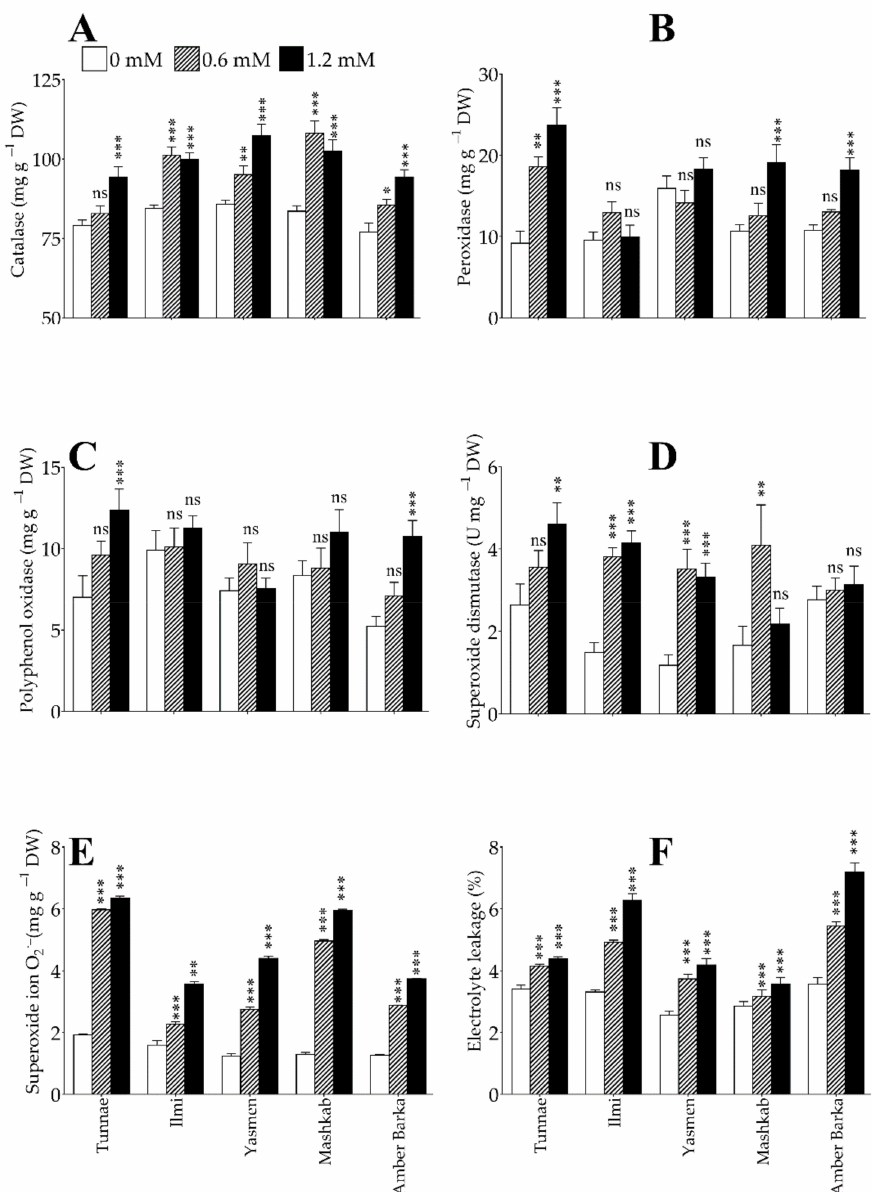
Figure 3. Changes in the antioxidant enzyme activity under Pb treatment. ( A ) Catalase activity in Tunnae, Ilmi, Yasmen, Mashkab, and Amber Barka in response to gradient lead (Pb) concentrations, ( B ) peroxidase (POD) activity, ( C ) polyphenol oxidase (PPO) activity, ( D ) superoxide dismutase (SOD) activity, ( E ) superoxide anion, and ( F ) electrolyte leakage. Bars are mean values ± SE. White bars are controls (plants grown without Pb treatment), striped bars and black bars are plants treated with 0.6 and 1.2 mM Pb, respectively. *** p < 0.001, ** p < 0.01, * p < 0.05, ns :